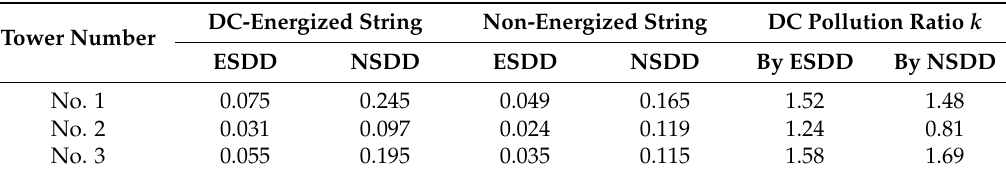
Table 2. Pollution test results for field operating insulators.